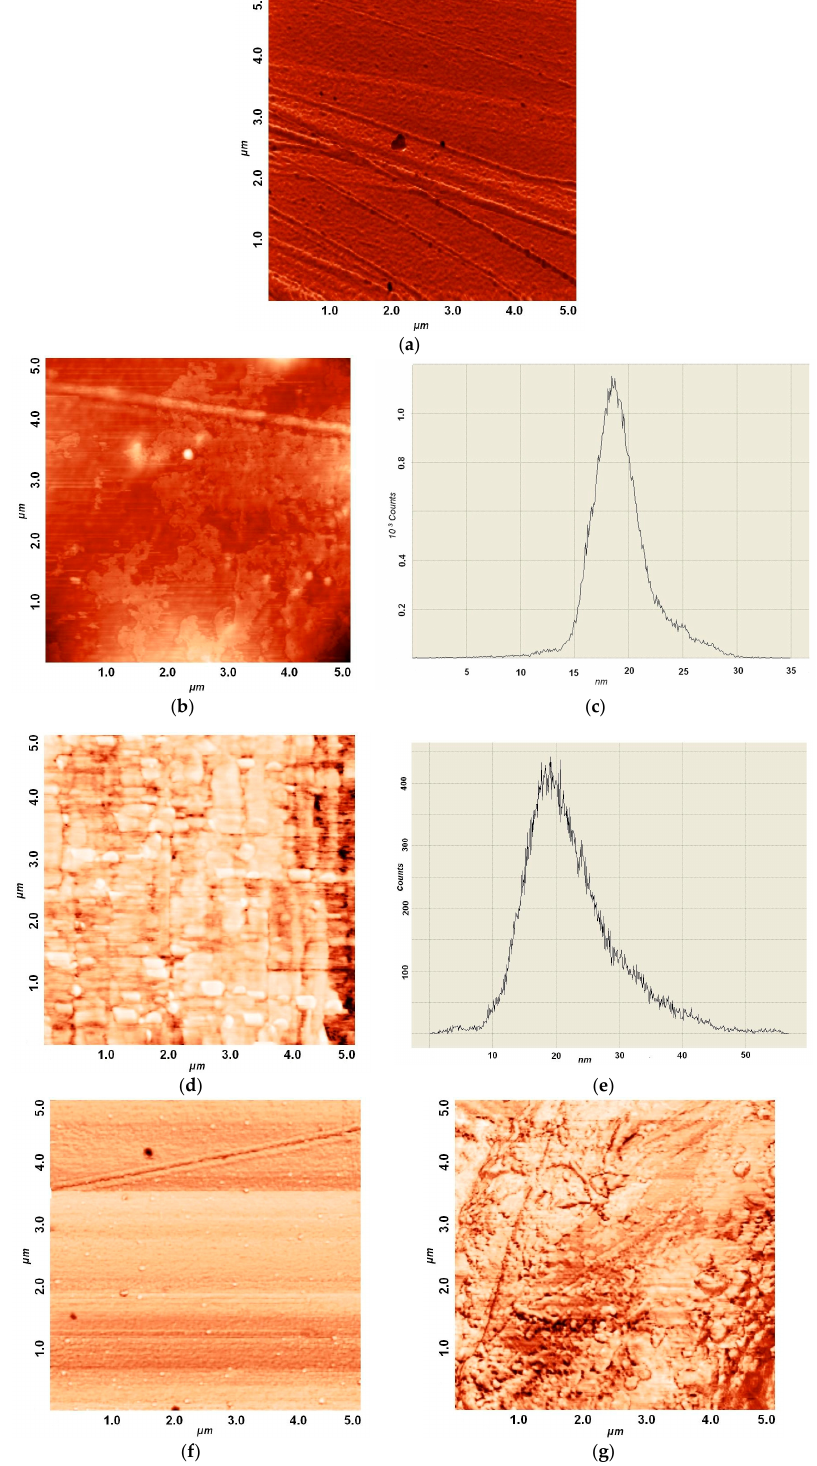
Figure 4. Images of the polyester film surface: ( a ) before processing; ( b ) with a coating deposited from a UPTFE FORUM ® solution in SC-CO 2 ; ( c ) height histogram of the coating deposited from a UPTFE FORUM ® solution in SC-CO 2 ; ( d ) with a TFE/AC telomer coating; ( e ) height histogram with a TFE/AC telomer coating; ( f ) with a TFE/BC telomer coating; ( g ) with a TFE/TMCS telomer coating. The study method is atomic-force microscopy. The representation method is phase contrast.